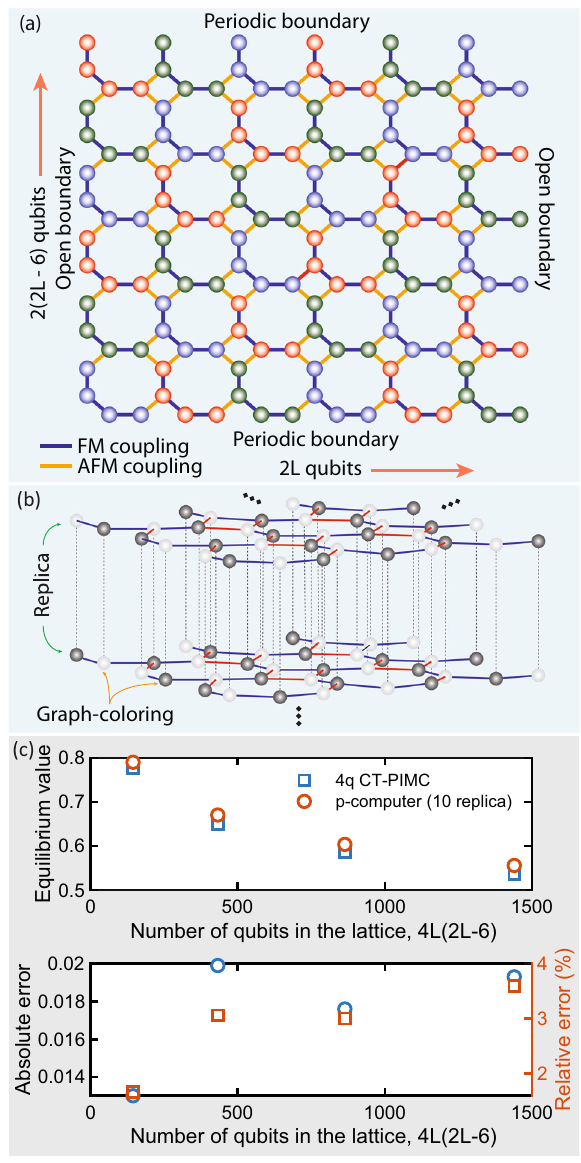
Fig. 2 Example problem addressed in this paper following King et al. 36 . a quantum problem solved on quantum annealing processor involves a two- dimensional square octagonal lattice of qubits having 2 L qubits in one direction and 2(2 L − 6) qubits in the other direction (illustration shows L = 6). The blue bond between two qubits denotes ferromagnetic (FM) coupling ( J FM = − 1.8) and yellow bond indicates antiferromagnetic (AFM) coupling ( J AFM = 1.0). The AFM couplings at the open boundary have J AFM = 0.5, b Trotterized mapping solved on classical computers, c Trotter error with 10 replicas: (Upper panel) Equilibrium values predicted from 10 replica probabilistic computer emulation and four qubit continuous time path integral Monte Carlo (4q CT-PIMC) algorithm developed in ref. 36 (red hollow circles: p-computer data, blue hollow squares: 4q CT-PIMC data). (Lower panel) Absolute (blue hollow circles) and relative errors (red hollow squares) in predicting equilibrium values between the two methods are